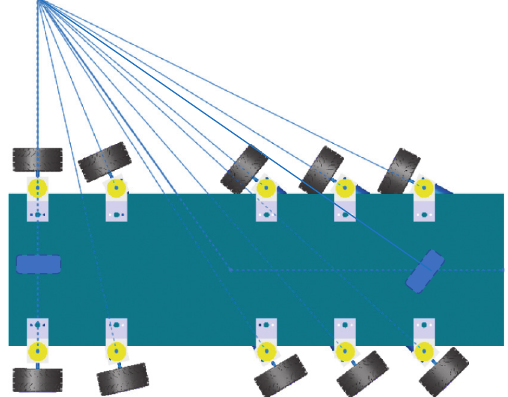
Figure 7: In situ rotation